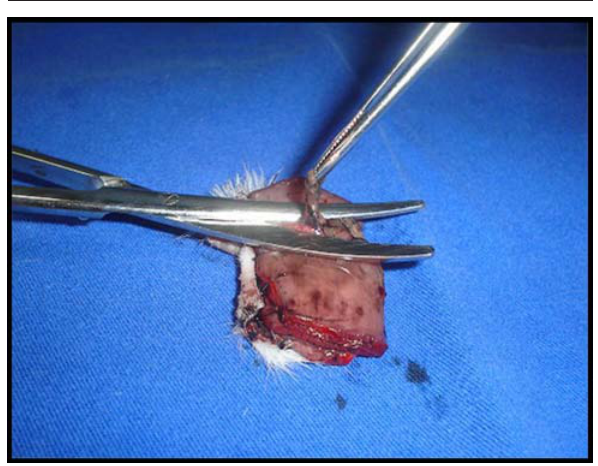
FIGURE 2 - Aspect of surgical wound after superior and lateral incisions, showing the adhesions between intestinal loops and parietal peritoneum, and the section site